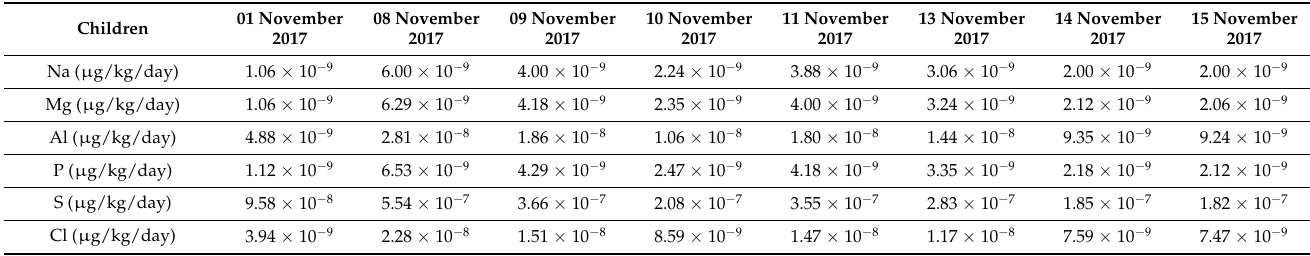
Table 9. Average daily dose ( µ g/kg/day) of different elements present in PM 2.5 for children during different days of